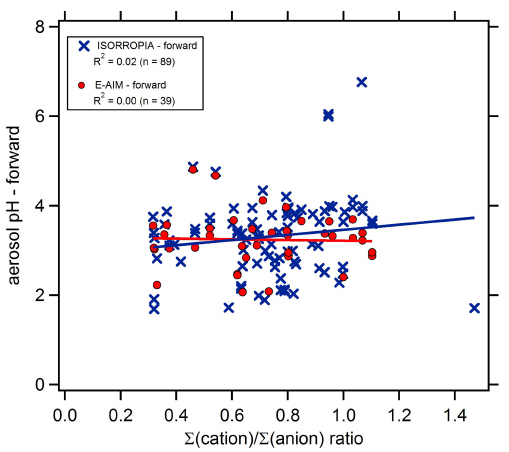
Figure 10. Predicted aerosol pH vs. the NH + ) molar ratio, using only data where the ratio is less than 2 ∗ SO 2 − 4 0.75 (region inferred as highly acidic) and where (cid:54) (NH + + SO 2 − ) accounts for greater than 95% of measured inor- NO − 3 4 ganic aerosol mass (i.e., with low crustal